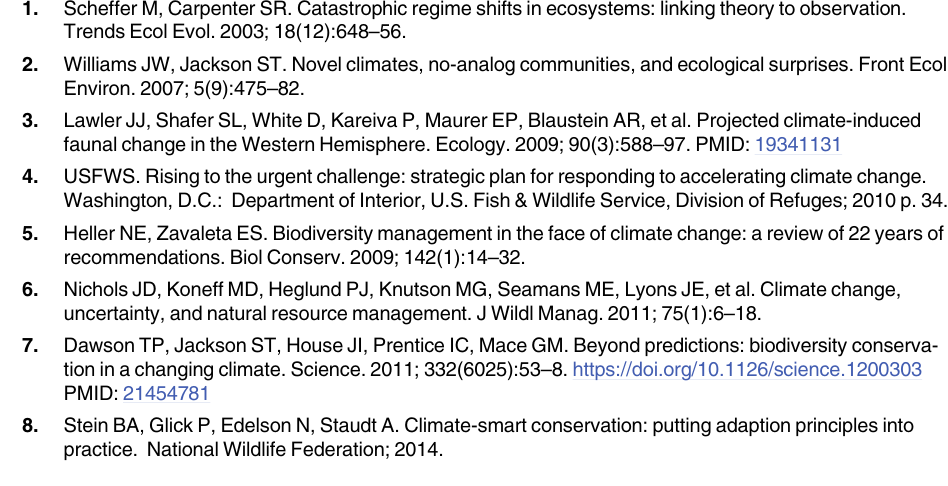
S2 Table. KP_Landcover_2050_AverageRFscores.csv. Table of cell locations on the Kenai Peninsula, Alaska with Random Forest outputs forecast to 2050 climate conditions under RCP45 and RCP85. S3 Table. KP_Landcover_2080_AverageRFscores.csv. Table of cell locations on the Kenai Peninsula, Alaska with Random Forest outputs forecast to 2080 climate conditions under RCP45 and RCP85. S4 Table. KP_Landcover_2080_Forecast.csv. Table of cell locations on the Kenai Peninsula, Alaska with forecast vegetation community based on 2080 climate conditions using 3 GCMs and 2